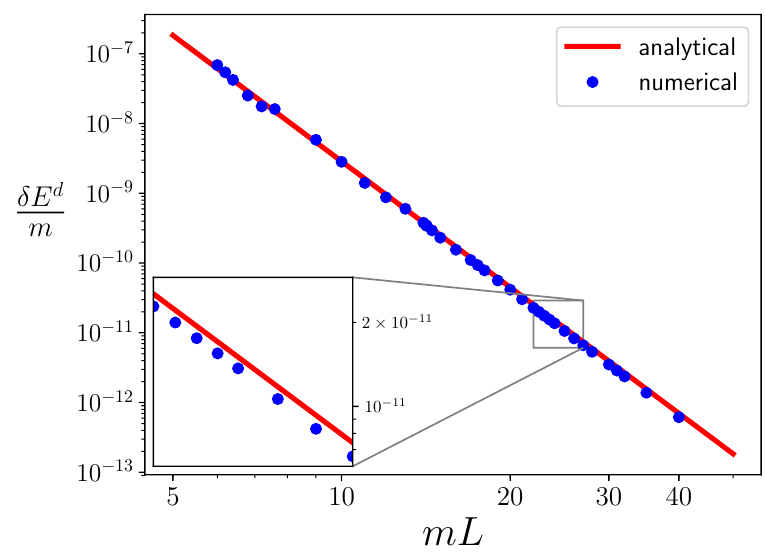
Figure 2. Comparison of the analytical prediction (which is absolutely normalized) with the results from a numerical solution of the quantization condition. The parameters are ma 0 = 0 : 1, ma 2 = 0 : 25, and r 0 = P 0 = = 0. The lack of linearity for smaller values of mL is related to K df ; 3 the opening up of new momentum